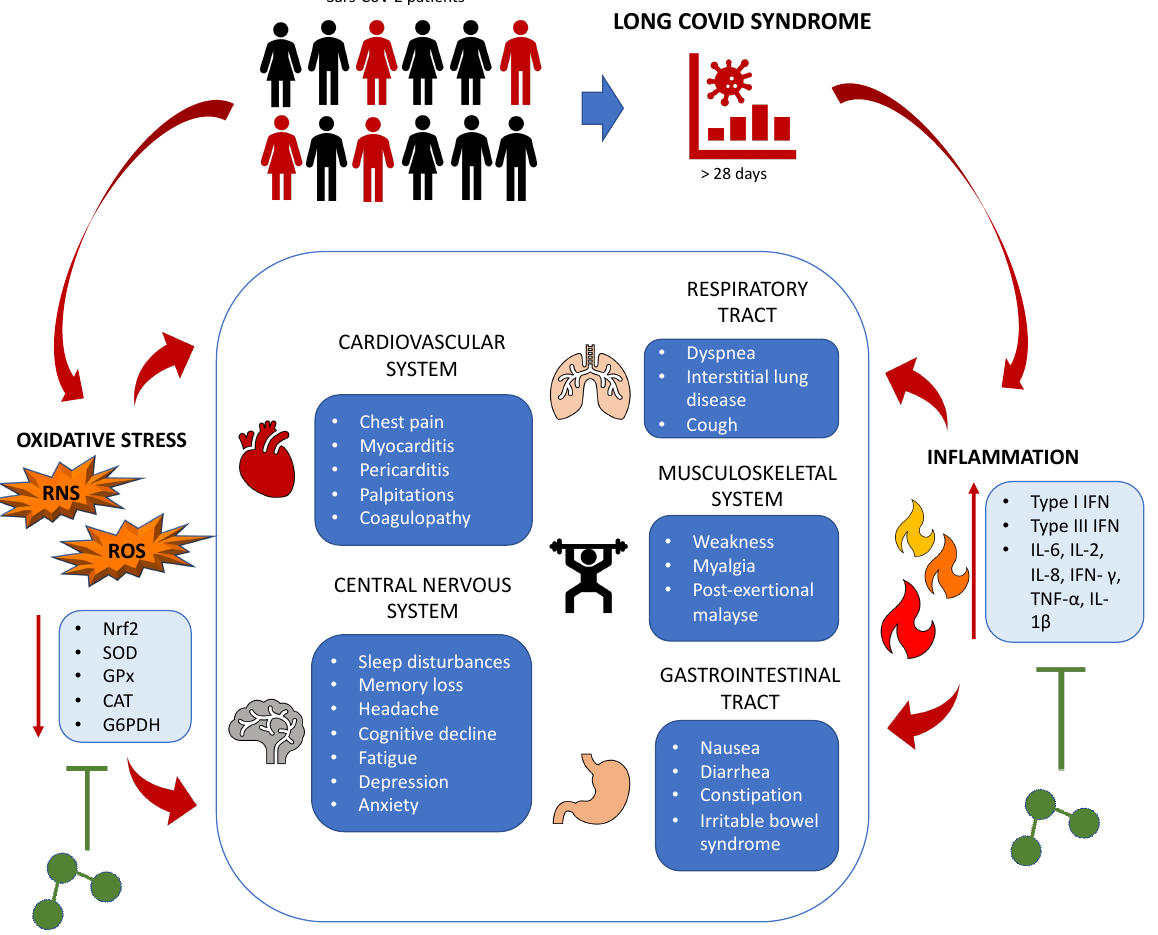
Figure 2. Possible therapeutic benefits of medical ozone in the treatment of PASC. PASC affects approximately one third of COVID-19 patients and is characterized by cardiovascular, respiratory, musculoskeletal, gastrointestinal, and brain dysfunctions. Oxidative stress and prolonged inflamma- tion are thought to be responsible for the onset of these PASC-related disorders. The ability of ozone to re-establish the correct oxidant/antioxidant balance as well as its anti-inflammatory activity might be helpful in PASC treatment and/or prevention. Ozone is represented by the picture with 3 green circles. Abbreviations: CAT: catalase; G6PDH: glucose-6-phosphate dehydrogenase; GPx: